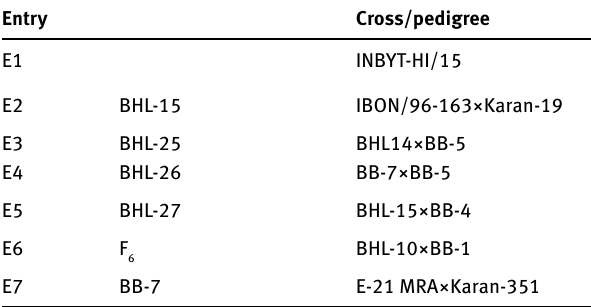
Figure 1: Meteorological condition during (2016-2017) crop growth stages in three locations Table 1: Seven barley genotypes and their pedigree, evaluated under different